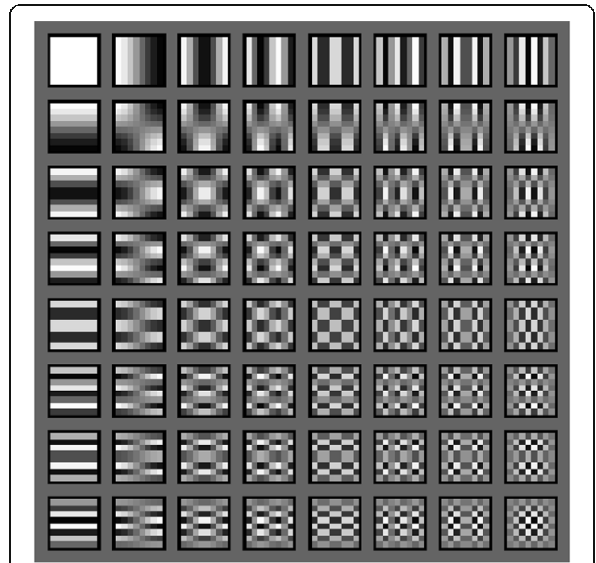
Fig. 10 Spatial frequency components of the 8 × 8 DCT